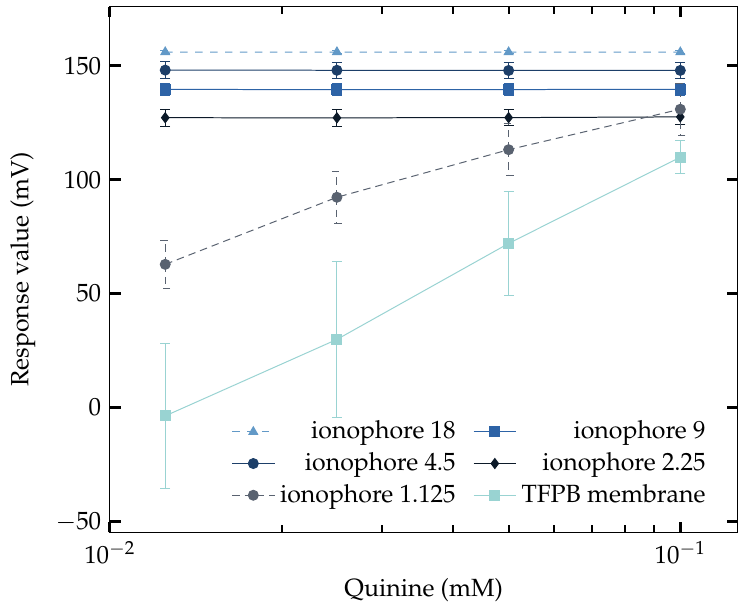
Figure 4. Responses of NaISE of different Na + ionophore concentrations to NaCl (200 mM) + quinine solutions.